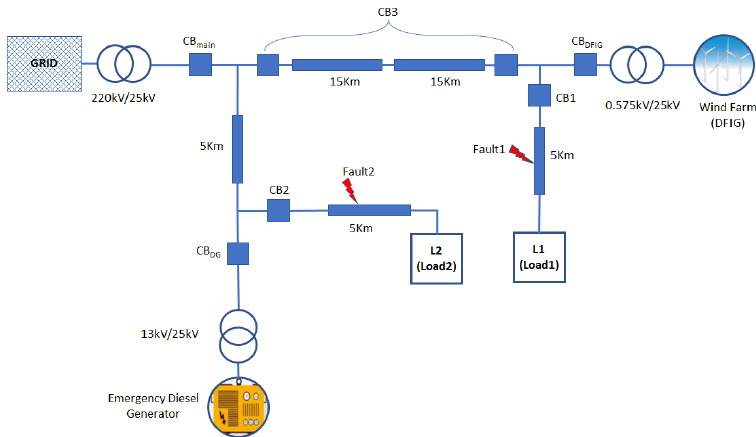
Figure 1. System protection scenario for the proposed interconnected distribution network.